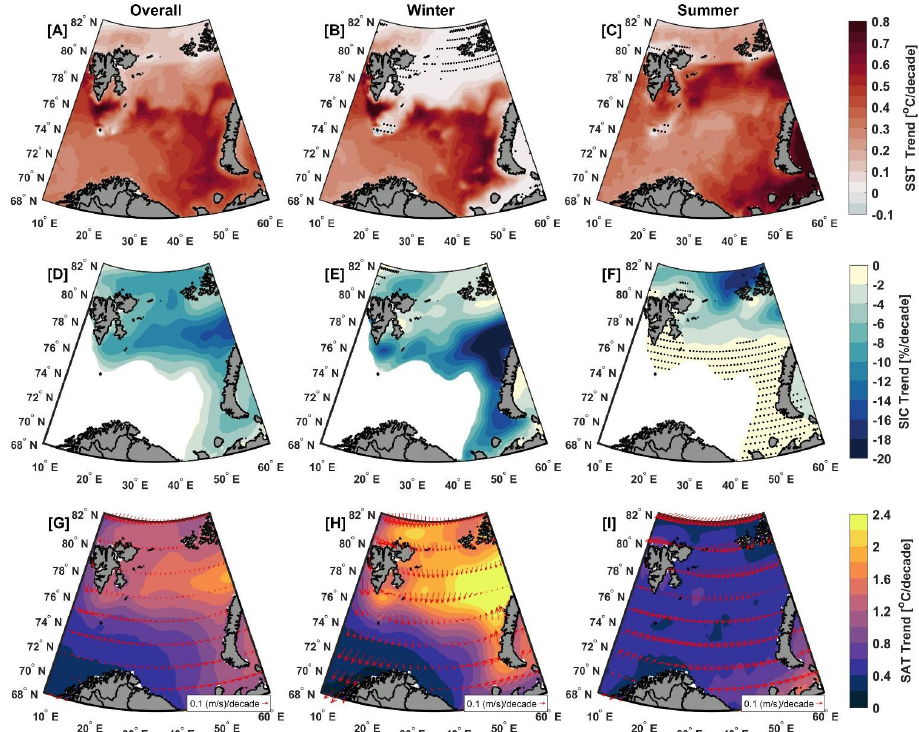
Figure 8. Spatial distribution of averaged de-seasoned trends of SST (top panel), SIC (middle panel), and SAT with corresponding trends of surface winds (arrows) overlaid (bottom panel). ( A , D , G ) overall, ( B , E , H ) in winter, and ( C , F , I ) in summer between 1982 and 2020. The white region in the middle panel indicates that SIC was below the climatological mean for the April sea-ice edge (15%) throughout the entire period. Non-significant values are indicated by black dots.